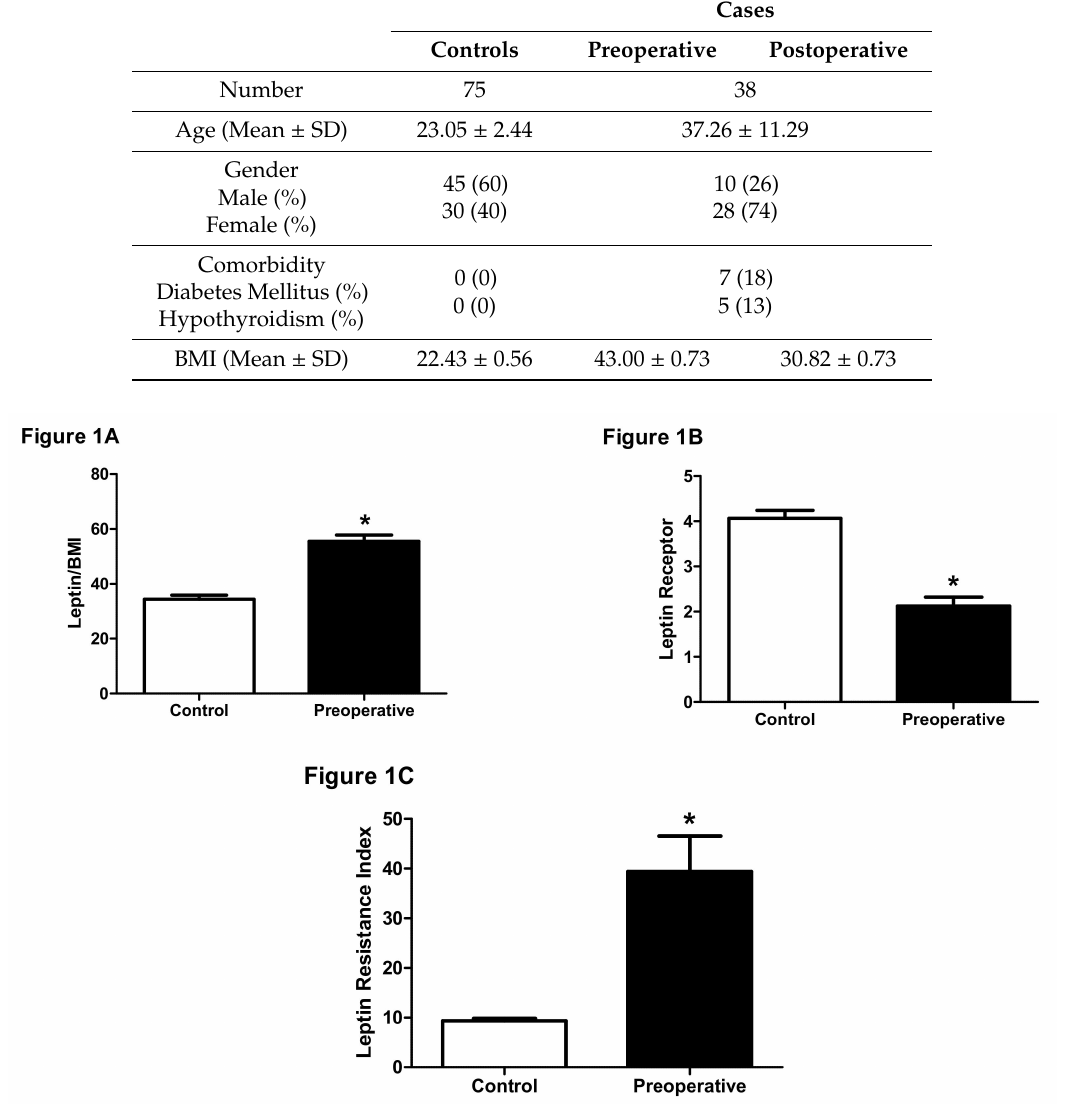
Figure 1. Comparison between controls and obese patients preoperatively. ( A ) Comparison between controls with normal Body-Mass Index (BMI) and obese patients preoperatively in serum leptin / BMI. * p < 0.05 vs. control; CI: 38.5–45.6. On the other hand, serum leptin receptor concentration was markedly decreased in obese patients ( p < 0.0001; CI: 3.1–3.7. ( B ) Comparison between controls with normal Body-Mass Index (BMI) and obese patients preoperatively in serum leptin receptor levels. * p < 0.05 vs. control; CI: 3.1–3.7. Due to the lack of a definitive measure of leptin resistance in relevant literature, we opted to adjust the leptin to BMI ratio to the corresponding leptin receptor concentration as a putative index of leptin resistance. Our findings showed that obese individuals have a significantly higher index of leptin resistance compared to controls ( p < 0.0001; CI: 14.2–24.7. ( C ) Comparison between controls with normal Body-Mass Index (BMI) and obese patients preoperatively in leptin resistance index. * p < 0.05 vs. control; CI: